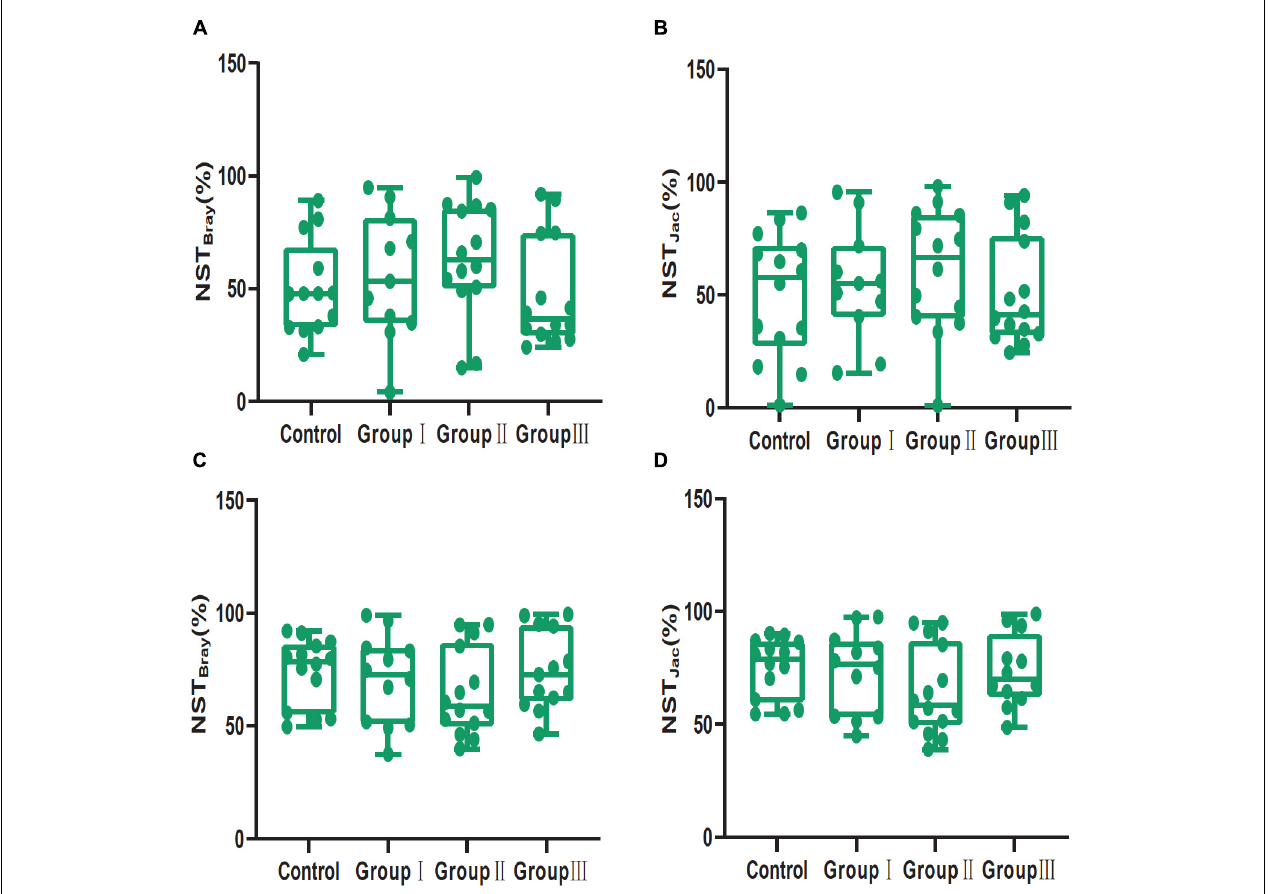
FIGURE 7 | Community assembly process measurements using NST indices based on Bray-Curtis (A,C) and Jaccard (B,D) distances for the four dietary fiber groups in the jejunal (A,B) and cecal (C,D)